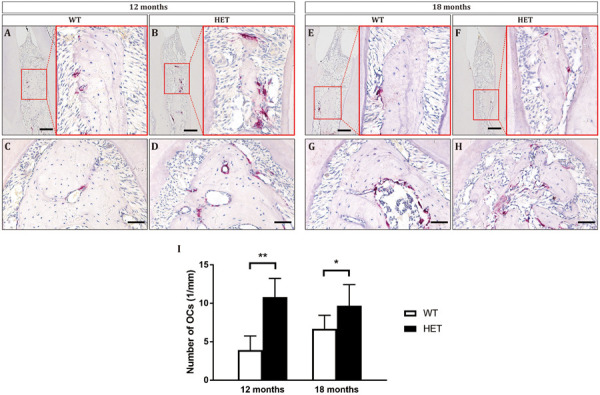
Osteoclasts were over-activated in Dspp heterozygous mice, leading to decreased alveolar bone mass and height at the ages of 12 months (A–D) and 18 months (E–H). Tartrate-resistant acid phosphatase (TRAP) staining showed the sagittal sections of the interdental septum between the mandibular first molars and the mandibular second molars (A,B,E,F), as well as sagittal sections of the furcation areas of the mandibular first molars (C,D,G,H). Scale bar in A,B,E,F = 50 μm. Scale bar in C,D,G,H = 20 μm. (I) The numbers of osteoclasts (TRAP positive with no less than three nuclei) on the surface of alveolar bone were counted. For each group, n = 3. *P < 0.05; **P < 0.01.